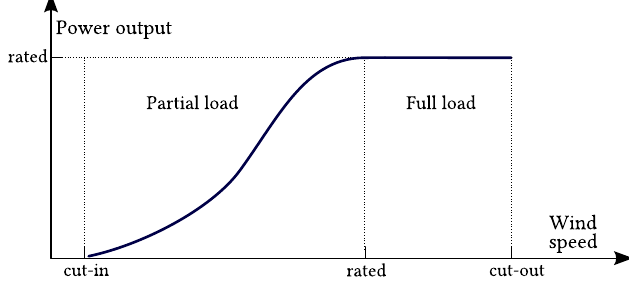
Figure 8. Typical power curve of a wind turbine